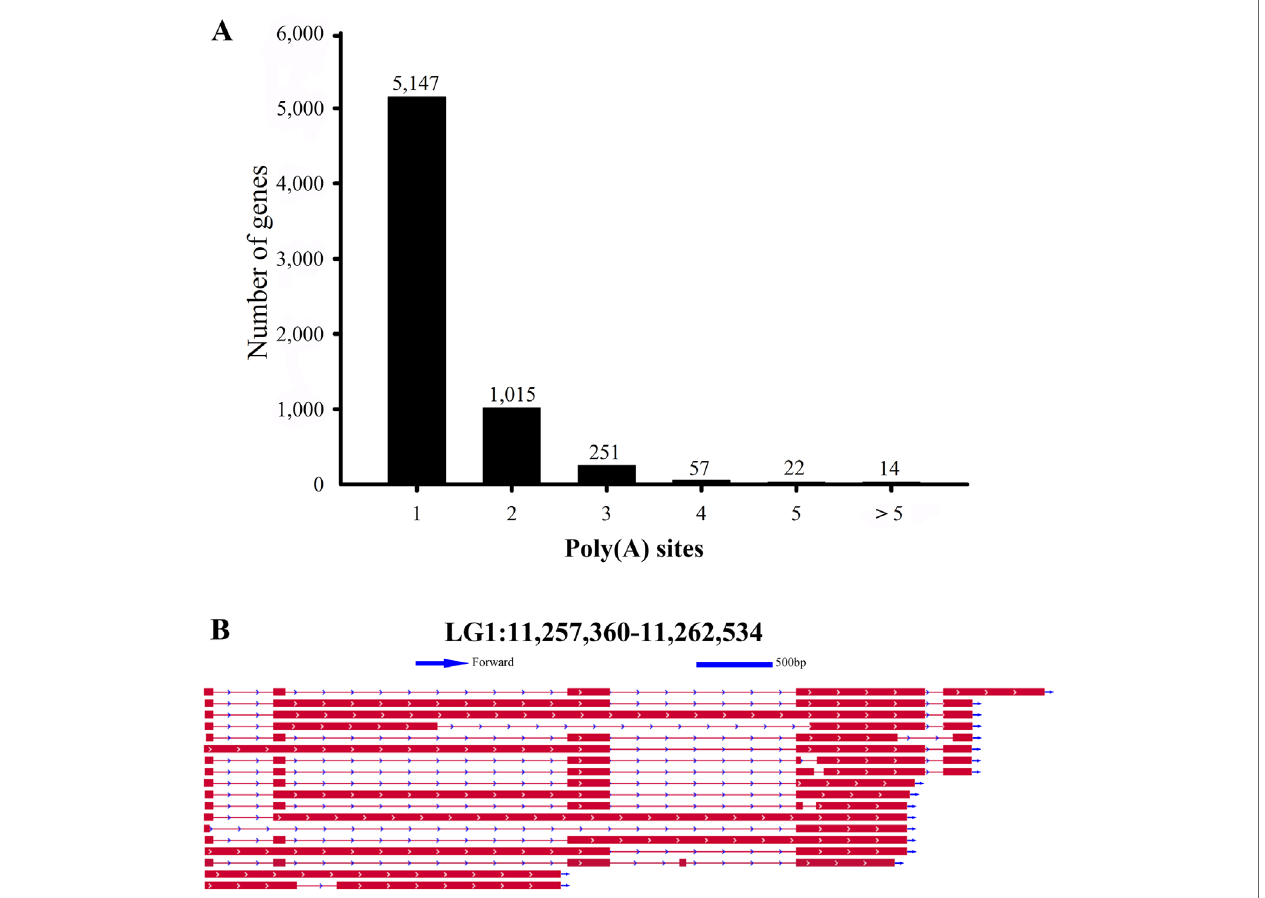
FIgURe 5 | Statistics of identified Alternative polyadenylation (APA) events. (a) Distribution of the number of poly(A) sites per gene. (B) IGV view of haptoglobin gene with APA events.